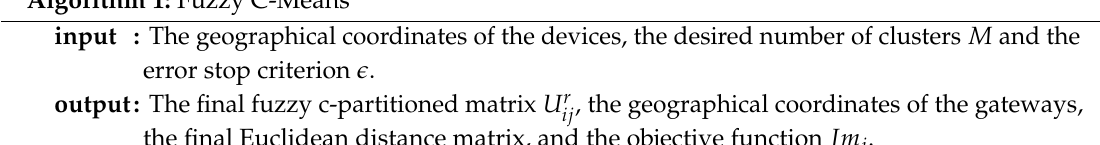
Algorithm 1: Fuzzy